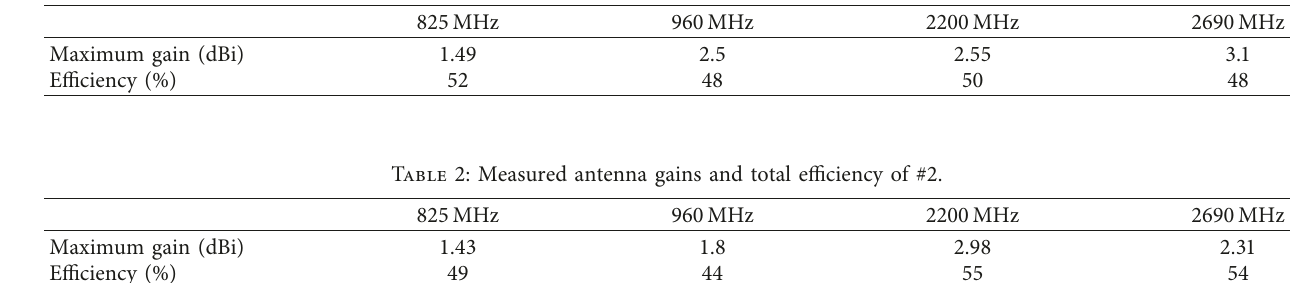
Figure 5: Envelope correlation coefficient of the proposed antenna system. Table 1: Measured antenna gains and total efficiency of #1.